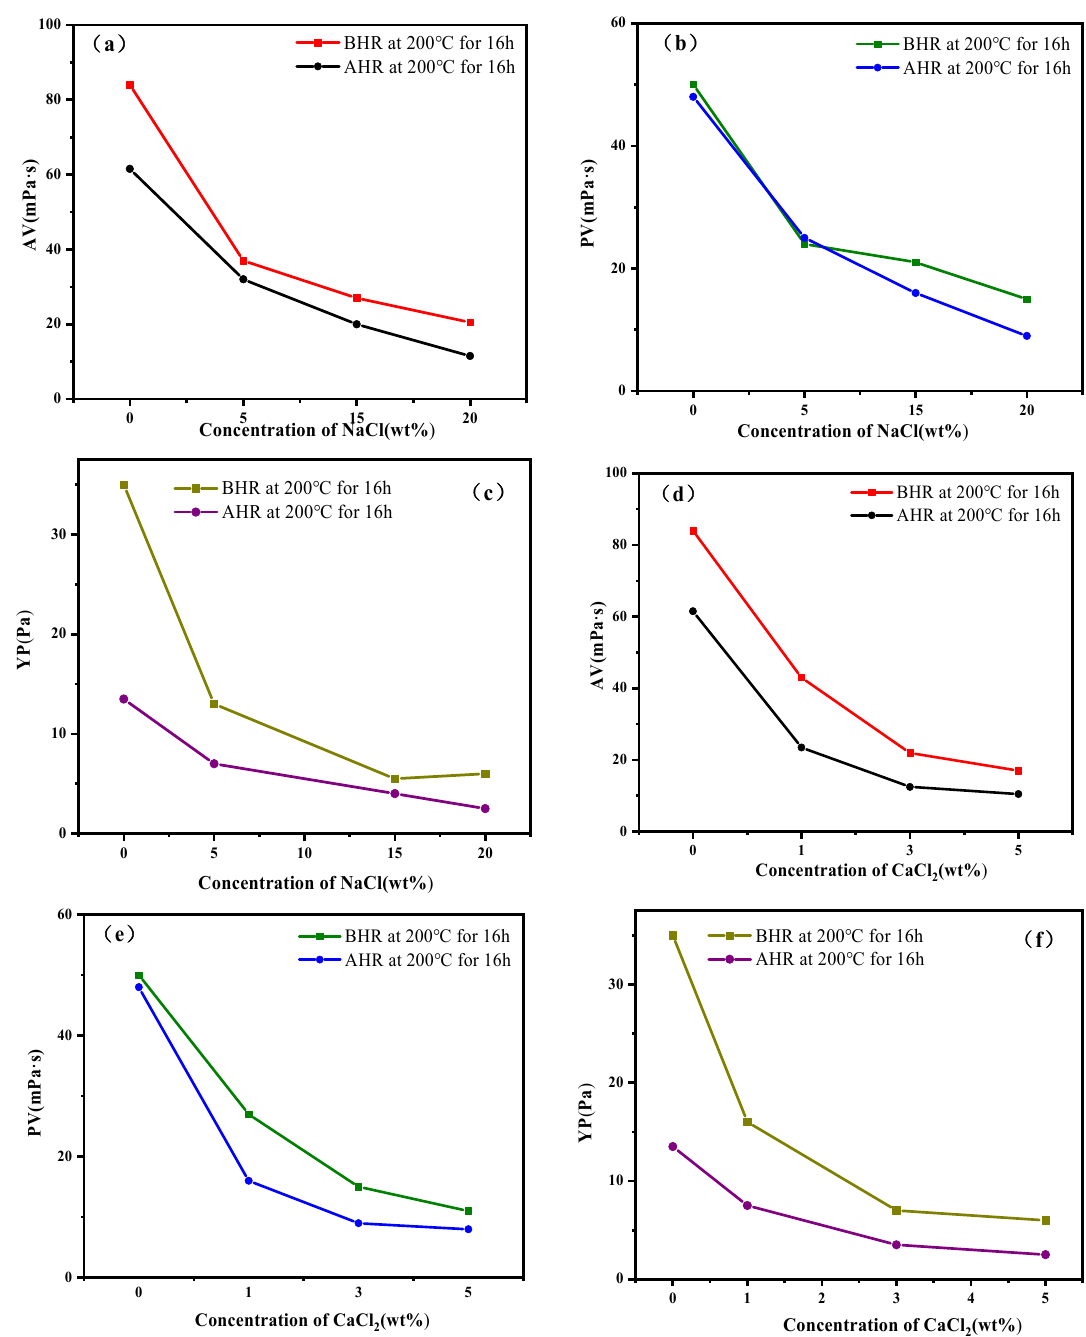
Figure 6. Rheological parameters of DNDAP before and after aging in WBDF with different salt and calcium concentrations. ( a – f